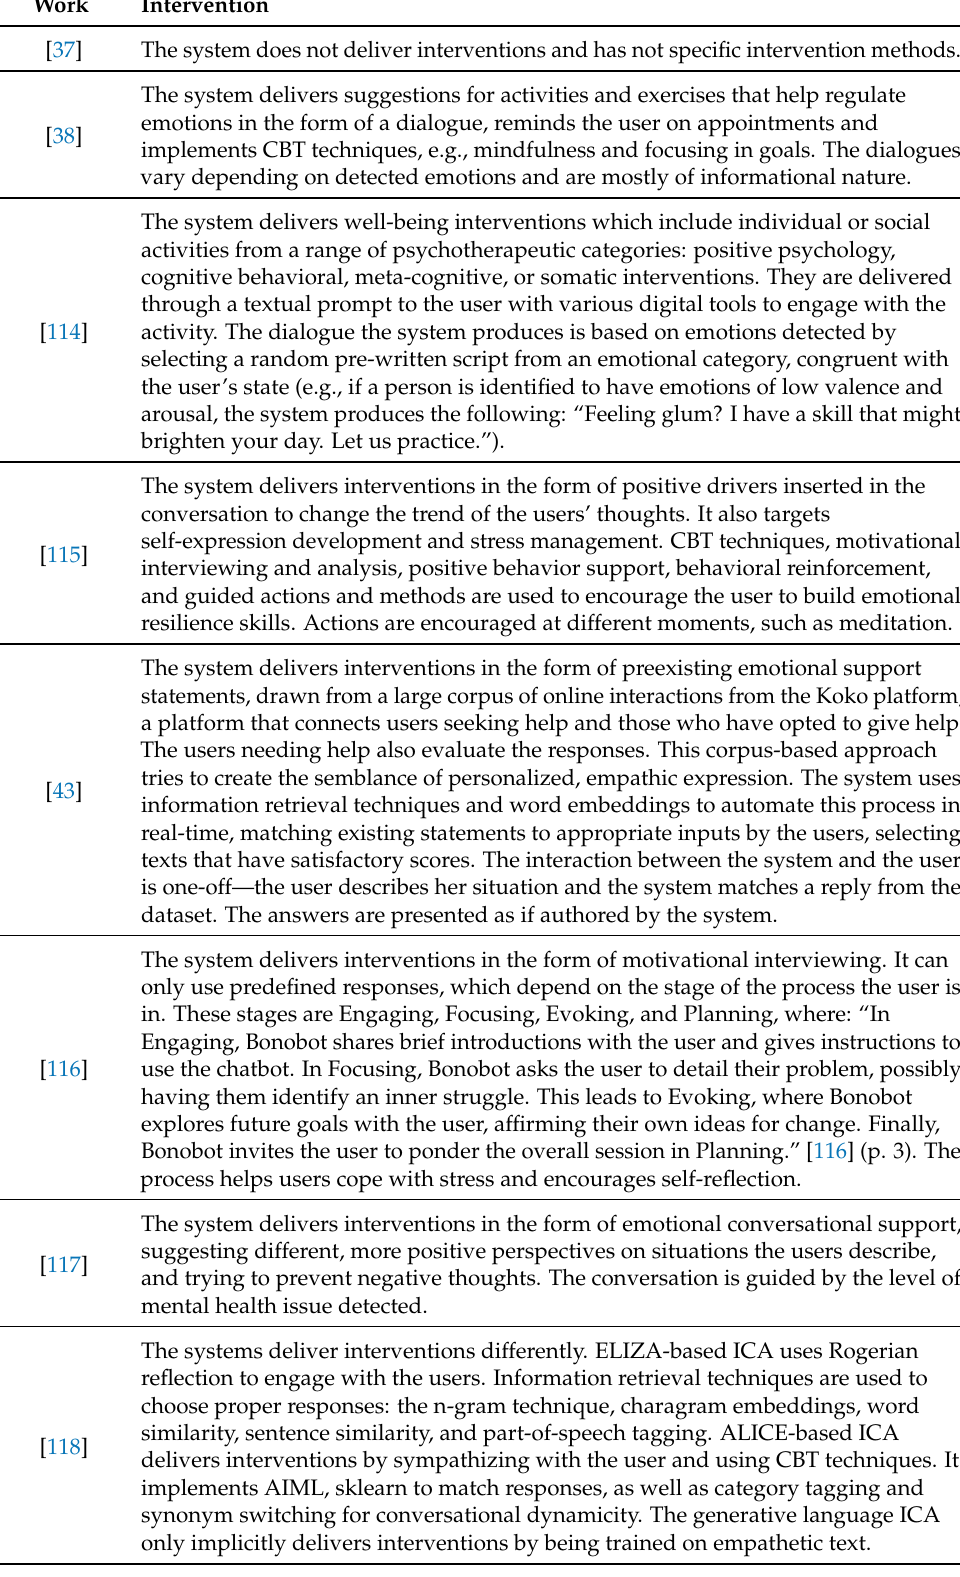
Table 3. Answering RQ2. Which technologies, methods and collected data guide the process to achieve ABC for SAD in the systems? Second step in the process: